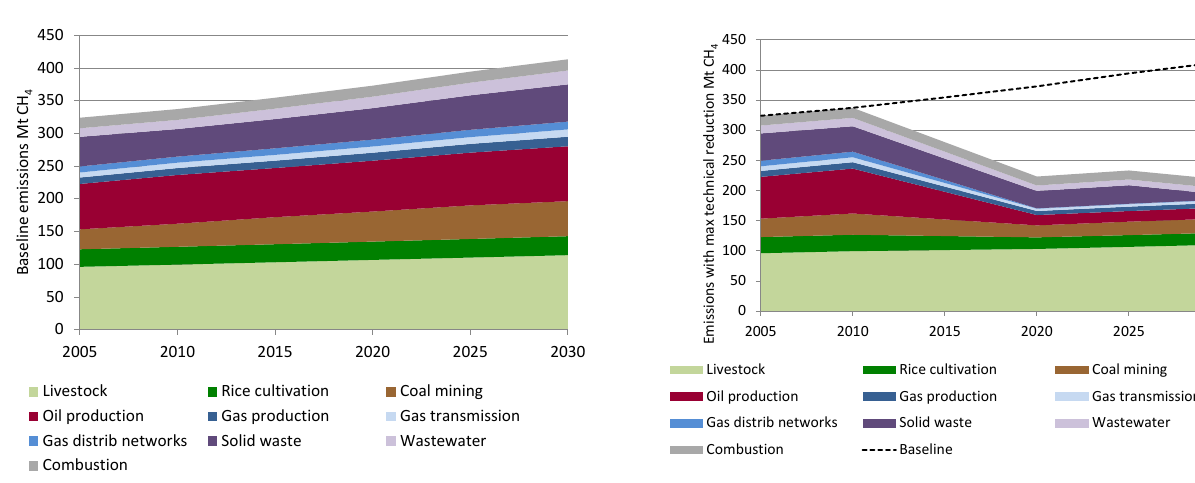
Fig. 2. Global anthropogenic CH 4 baseline emissions 2005 to 2030.